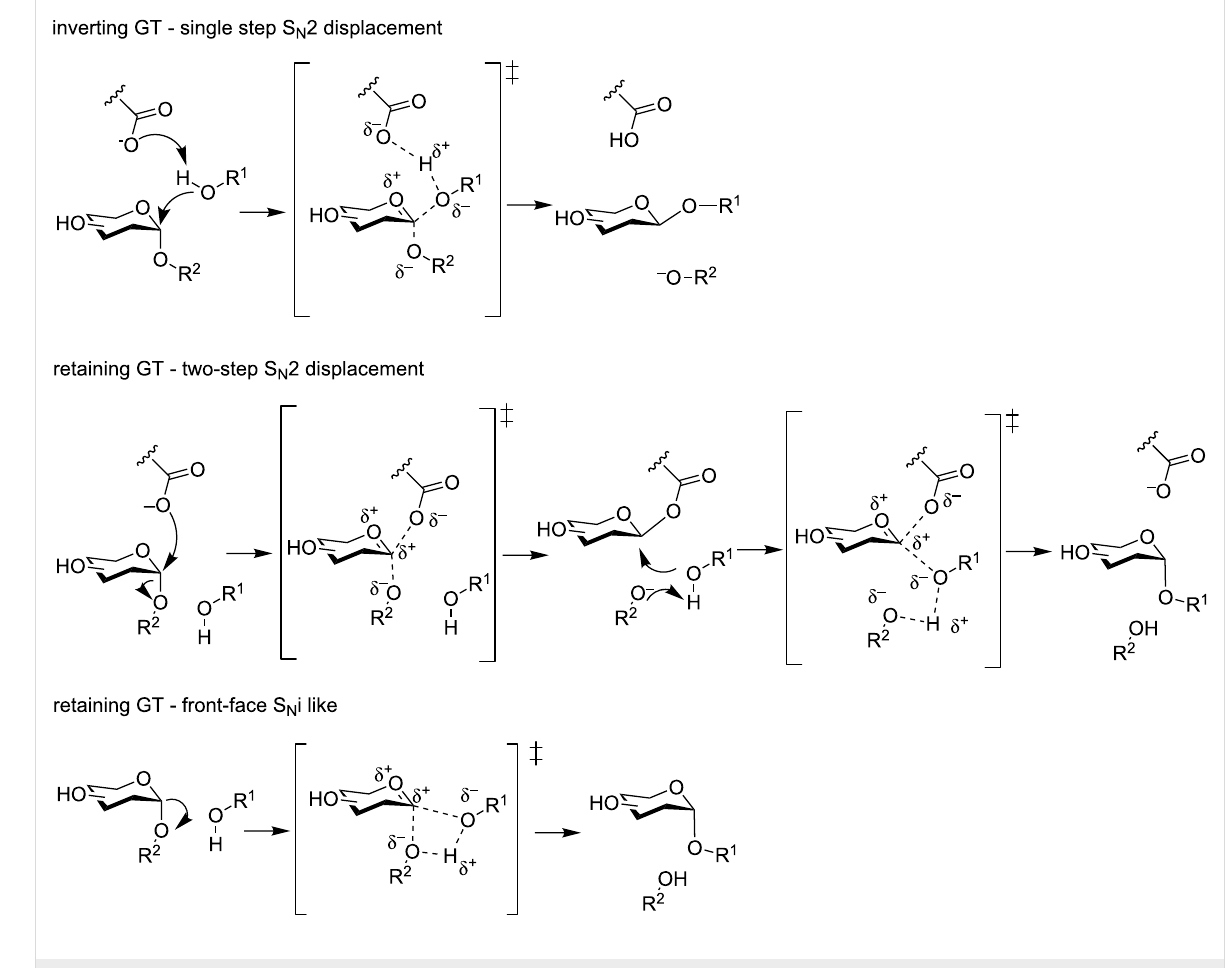
Figure 1: Mechanisms of O -GTs-catalysed